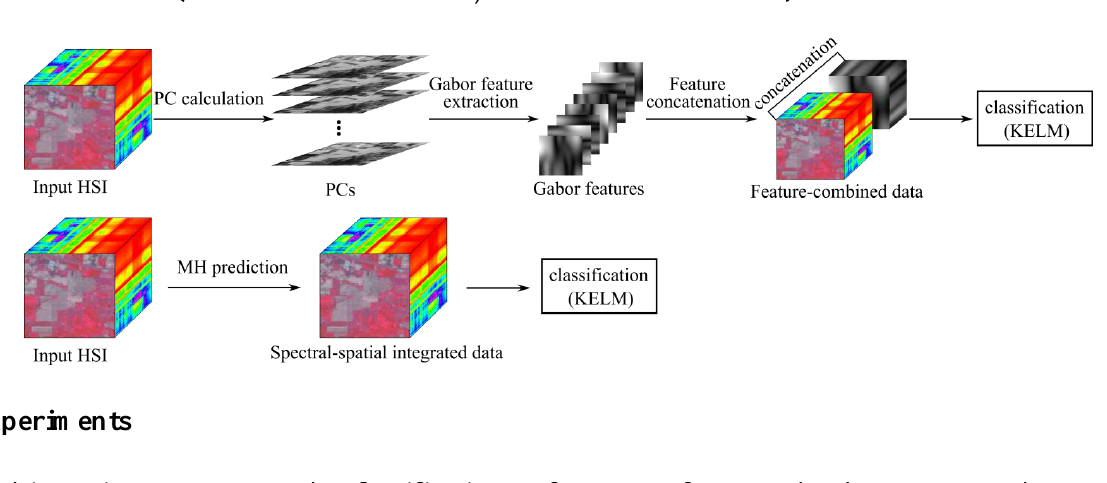
Figure 2. The proposed spectral-spatial KELM framework for hyperspectral image classification (first row: Gabor-KELM; second row: